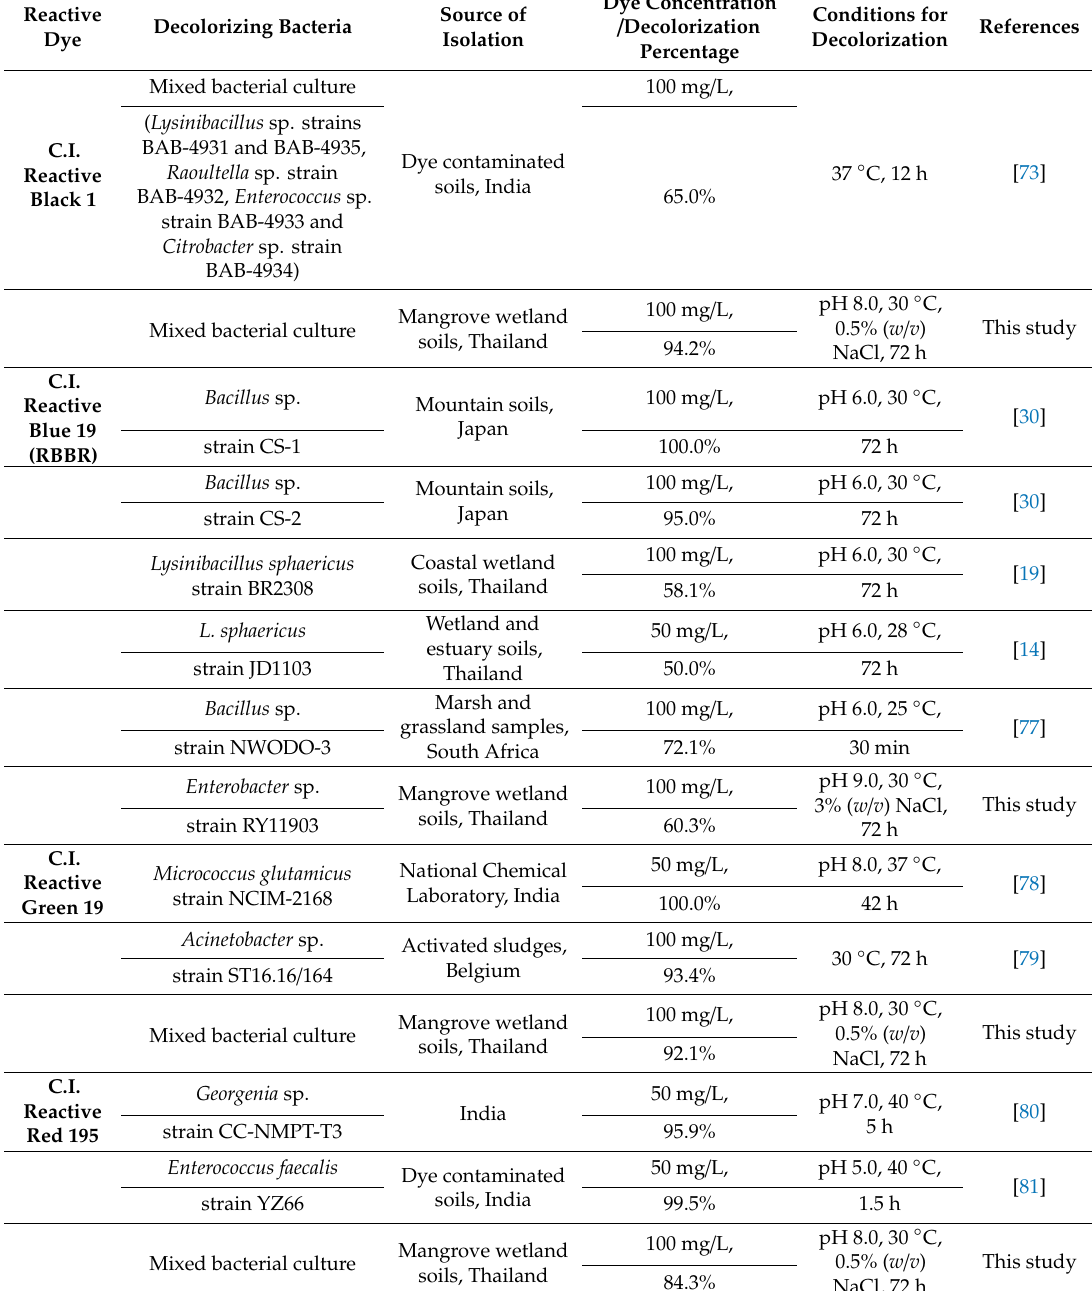
Table 6. Decolorization of some reactive dyes by isolated decolorizing-bacteria and other bacteria isolated from various